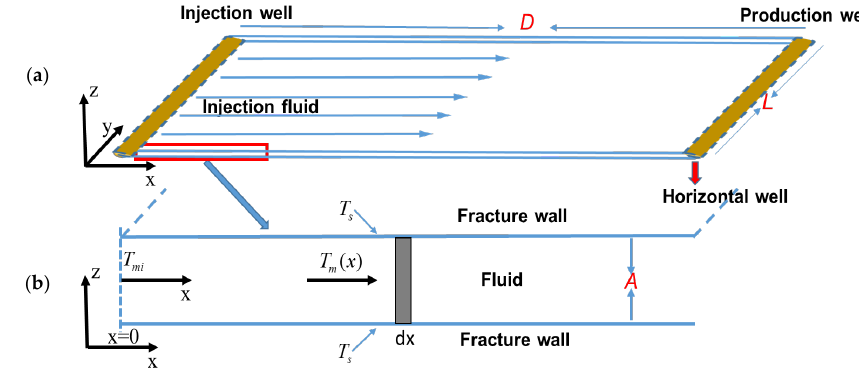
Figure 2. Schematic of abandoned hydrocarbon horizontal well system in terms of the corresponding physical model. ( a ) System comprises two horizontal wells connected by a single fracture plane. ( b ) Zoom in of the heat flow model within the fracture channel.